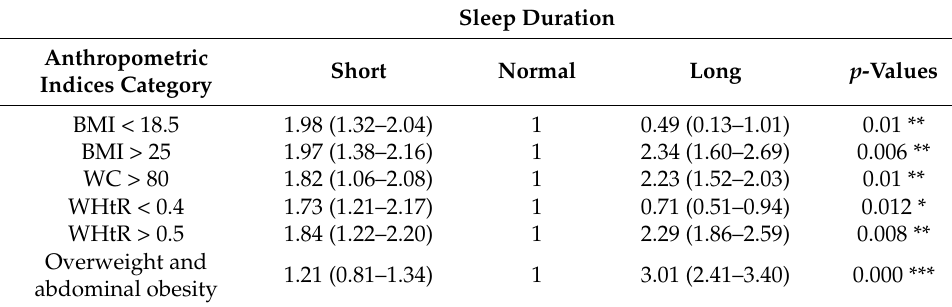
Table 1. The risk (OR and 95% CI) of underweight and overweight and abdominal obesity in relation to sleep